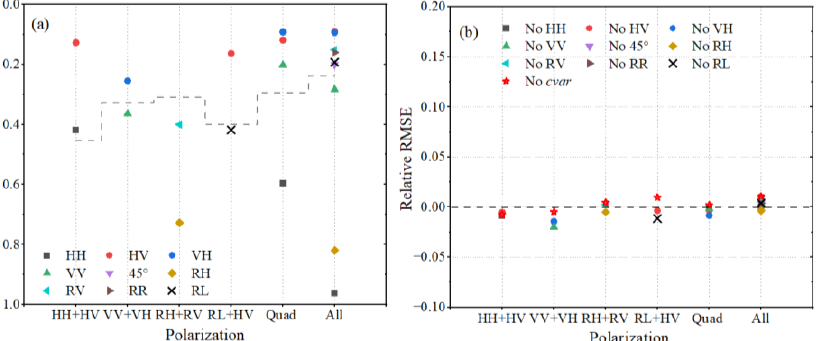
Figure 15. The importance of cvar to SWH retrieval from combined-polarization models. ( a ) The importance ranking of cvar provided by XGBoost models, normalized to the range of 0 – 1. ( b ) The effect of removing cvar on the SWH estimation from different polarized models. The red pentagrams represent the relative RMSE corresponding to the removal of cvar -terms in the combined-polariza- tion models.